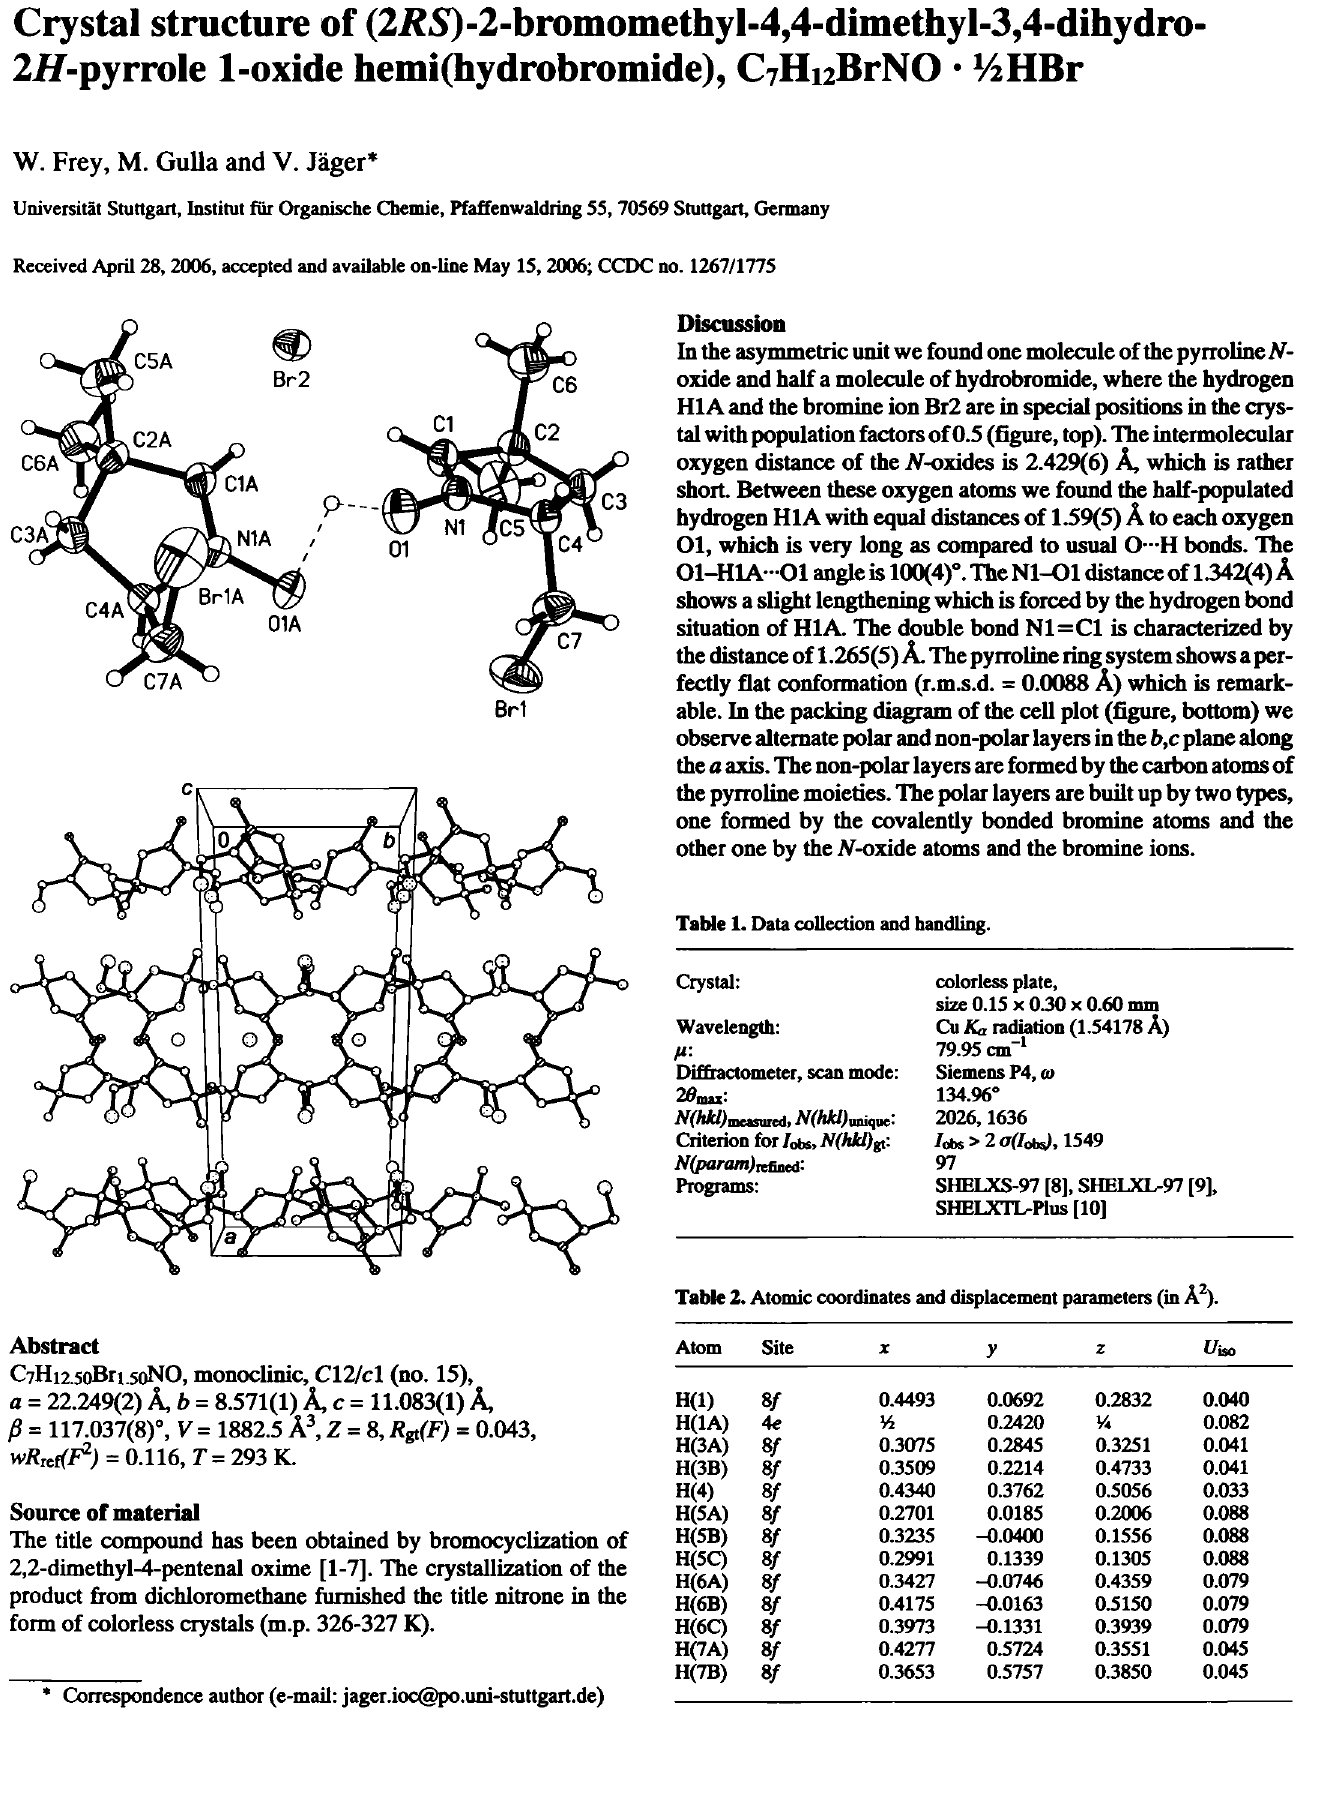
Table 2. Atomic coordinates and displacement parameters (in A 2